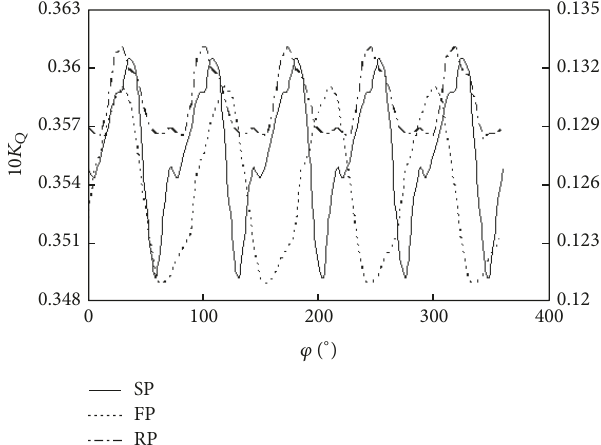
Figure 11: Torques over one revolution for single propeller (SP) and CRP (FP: front propeller, RP: rear